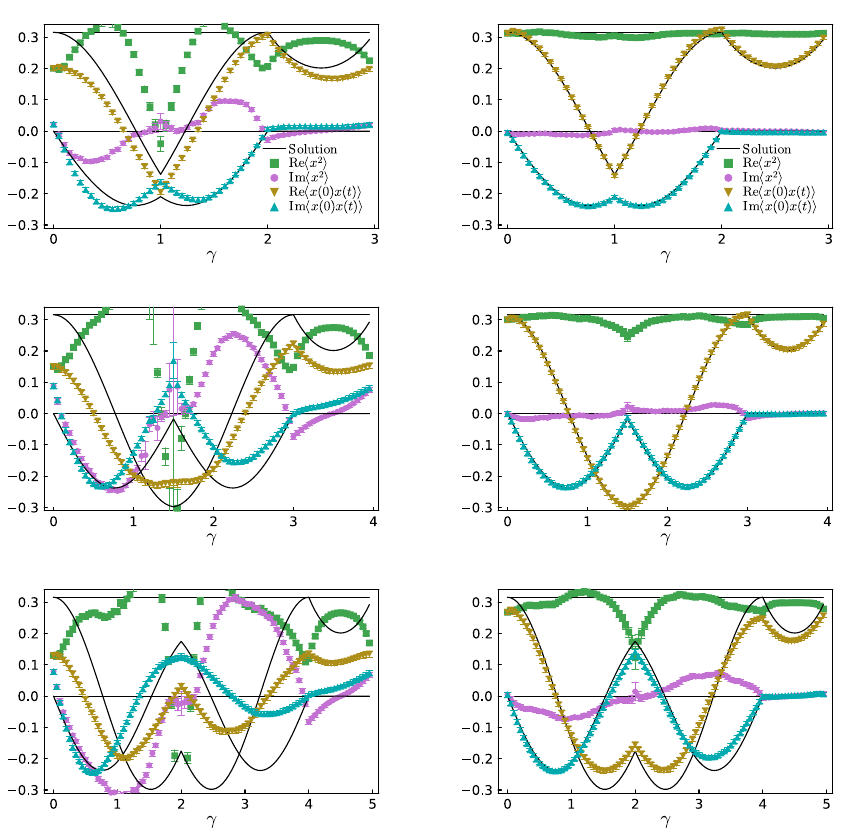
Figure 7 . Complex Langevin simulation of the strongly coupled anharmonic oscillator on the thermal Schwinger-Keldysh contour in the absence (left) of a kernel and in the presence of the optimal learned field-independent kernel (right). The top row corresponds to results from a contour with real-time extent mt = 1 , while the center row shows results for mt max row for mt = 2 . Values of the correlators from the solution of the Schrödinger equation are given max as solid black